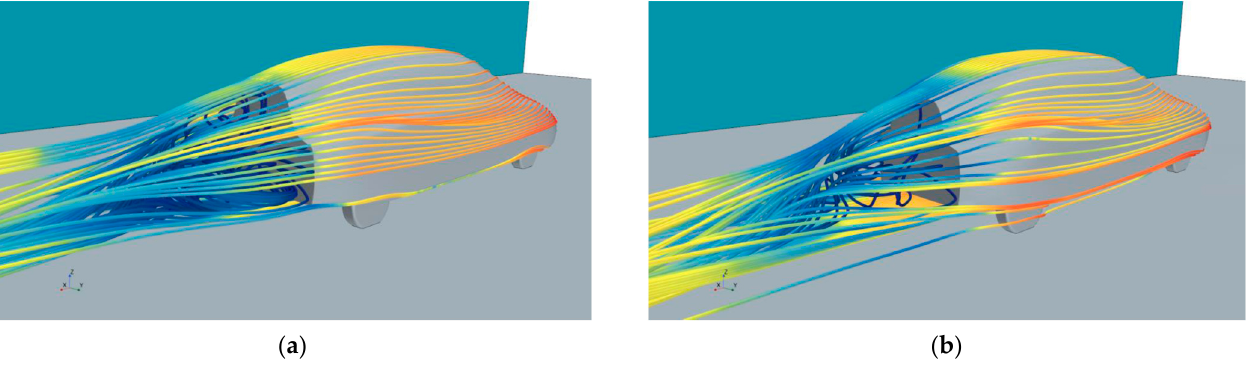
Figure 7. Comparison between baseline ( a ) and selected optimum ( b ) solution for the ASMO model.